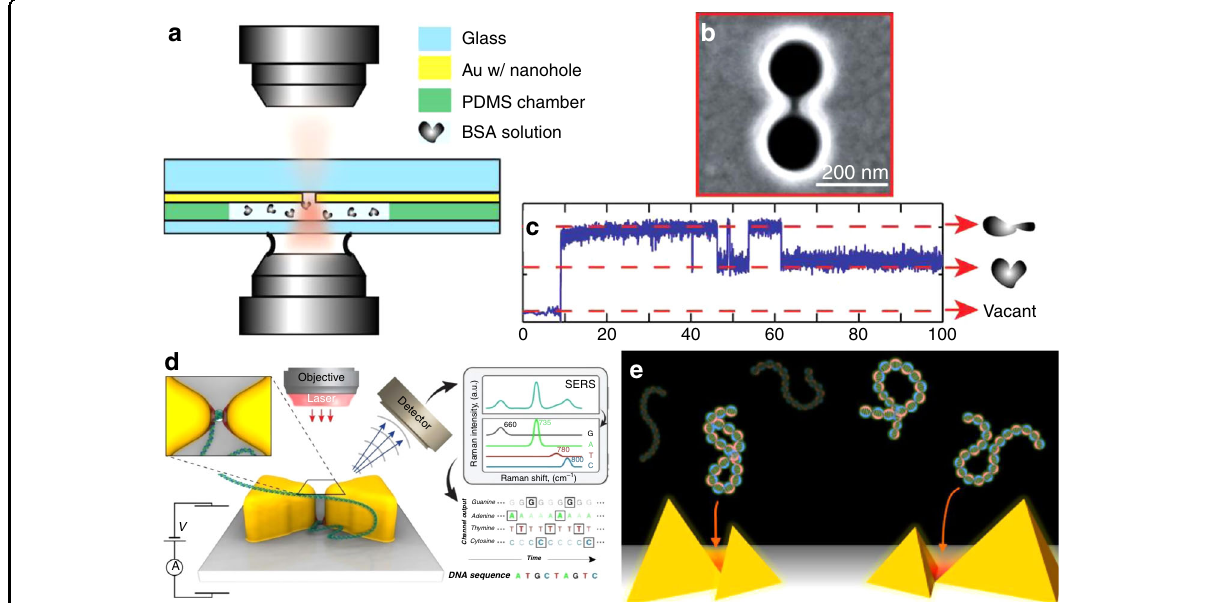
Fig. 13 Plasmonic trapping of biomolecules. a Schematic of plasmonic trapping of a biomolecule in a double nanohole. b Scanning electron microscopy image of the double nanohole used in the protein binding and control experiments. c Time traces of the optical power transmitted through the double nanohole with a BSA solution in PBS buffer with pH = 7.4 at an incident optical power of 13.4 mW. d Trapping of a DNA molecule by a plasmonic tweezer system combining a gold bowtie and a nanopore, where its nucleotide sequence could be deciphered through deconvolution of the SERS signals that uniquely identify each of the four DNA nucleotides. e Schematic illustration of plasmonic tweezers for DNA. a – c Reproduced with permission from ref. 112 , Copyright 2011 American Chemical Society. d Reproduced with permission from ref. 249 , Copyright 2015 American Chemical Society. e Reproduced with permission from ref. 215 , Copyright 2013 American Chemical